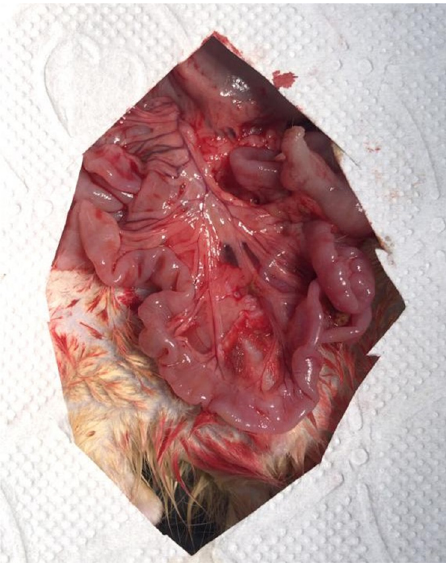
Figure 5: Surgical procedure before the histopathological